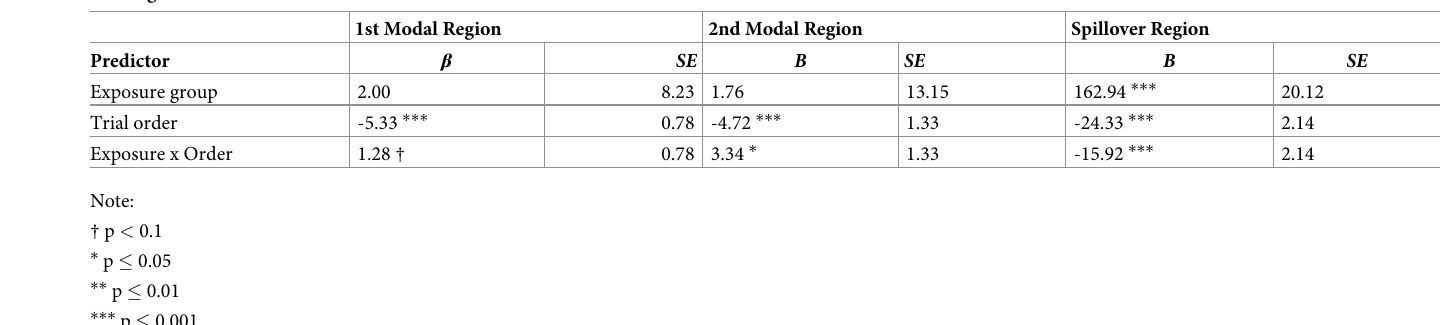
Table 4. Experiment 2 exposure block fixed effects summary for the three regions of analysis: The first modal region, the critical second modal region, and the spill- over region.